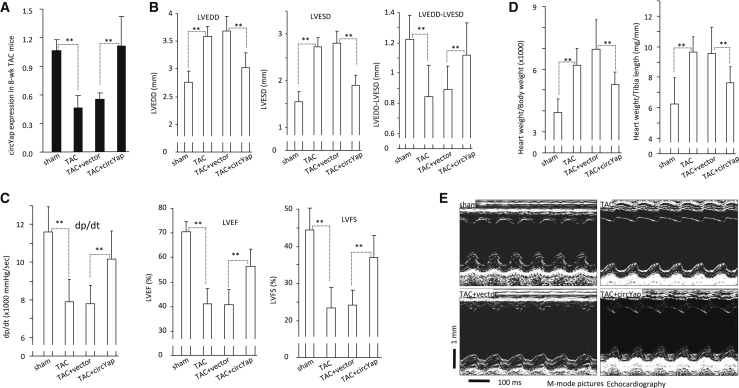
The Effects of circYap on Heart Function of Mice with Pressure Overload Induced by Transverse Aortic Constriction (TAC) Surgery(A) Expression of circYap in mice with TAC and/or circYap plasmid injection for 8 weeks. (B) Echocardiography showed that TAC increased left ventricular end-systolic diameter (LVESD) and left ventricular end-diastolic diameter (LVEDD) compared to the sham mice. Such changes of heart function parameter could be improved by injection of circYap plasmid. n = 10. ∗∗p < 0.01. (C) TAC reduced contraction velocity (dp/dt), left ventricular ejection fraction (LVEF), and left ventricular fractional shortening (LVFS) compared to the sham mice, while ectopic delivery of circYap could prevent these effects of TAC. n = 10. ∗∗p < 0.01. (D) TAC increased heart weight to body weight or tibia length ratio that was eliminated by ectopic delivery of circYap. n = 10. ∗∗p < 0.01. (E) Representative photographs of echocardiography from sham, TAC, TAC + vector, and TAC + circYap plasmid injection mice.